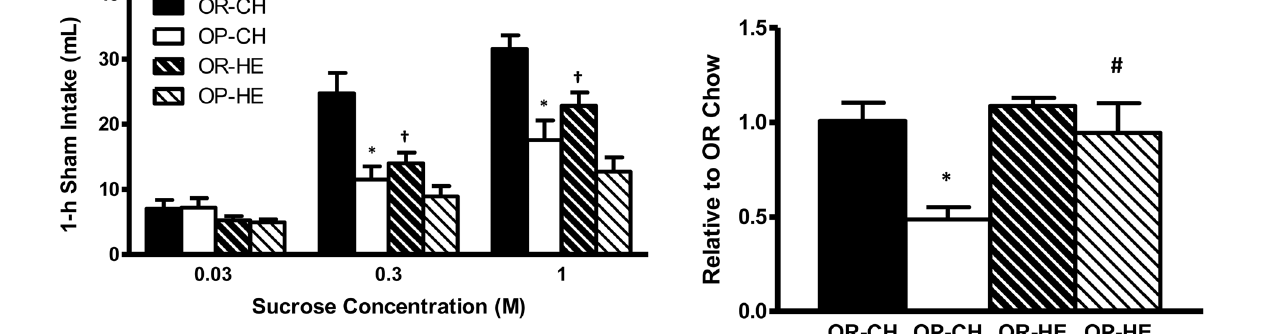
Figure 6. Gene expression of lingual T1R3 in OP and OR naı¨ve animals OP rats had reduced T1R3 mRNA in the posterior lingual epithelium relative to OR rats during chow-feeding. *P , 0.05 OP relative to OR within diet condition; # P , 0.05 HE-OP relative to chow-OP.